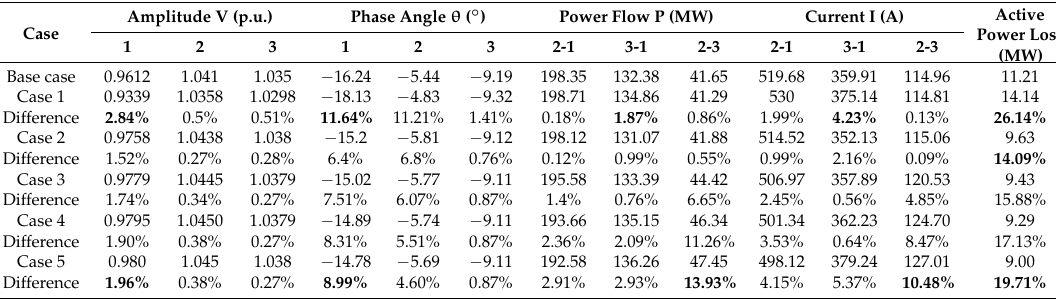
Table 9. The voltage, active power flow, current, and active power loss of the six